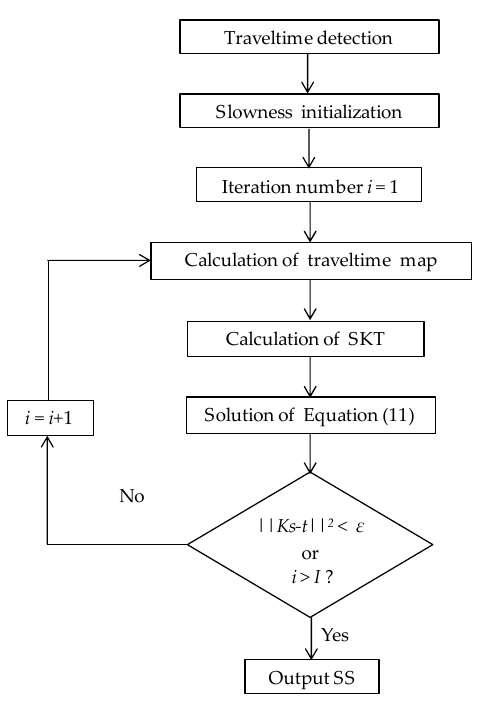
Figure 3. The flowchart of Fresnel zone travel-time tomography (FZTT) and zone-shrinking FZTT (ZSFZTT).